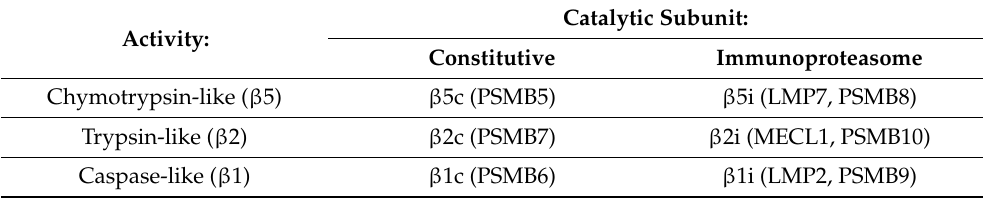
Table 1. The active sites of constitutive and immunoproteasomes. Activity: